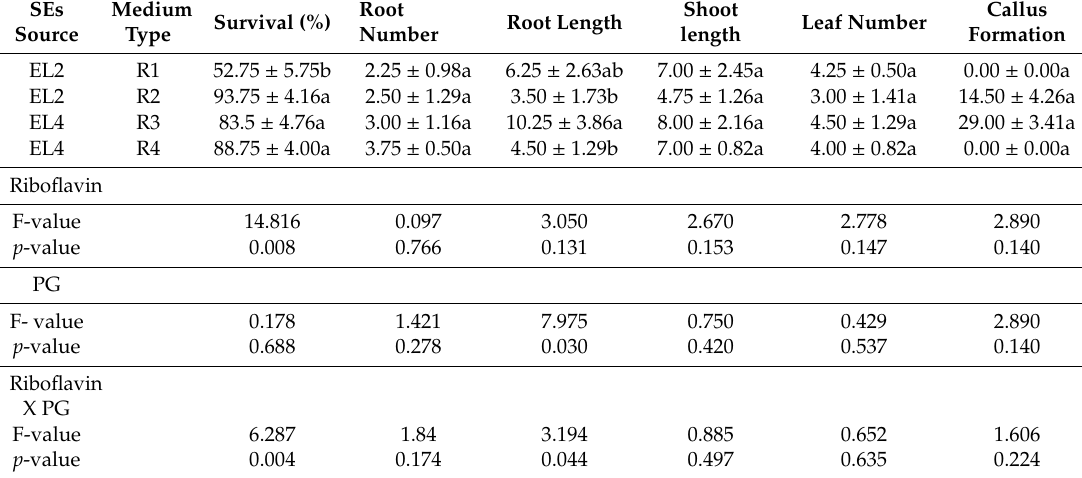
Table 6. Comparison of survival (%), root number, root length (cm), shoot length (cm), leaf number, and callus formation (%) at the base of SEs after 6 weeks of culture in di ff erent rooting media. All values are means ±